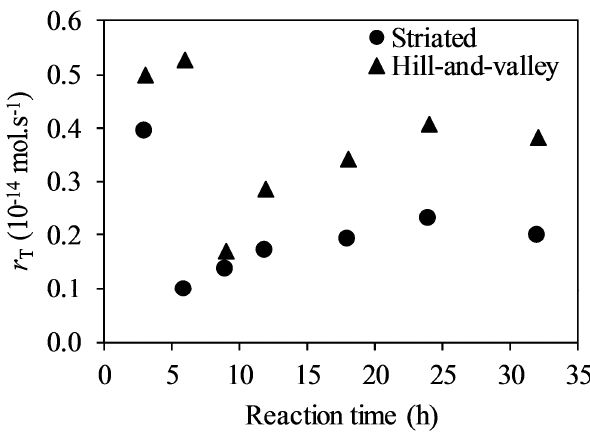
Figure 4. Total material flux rate ( r T ) change over time within the sub-sections in Figure 3c,d corresponding to striated and hill-and-valley surface morphologies, respectively. This rate was calculated from the total volume of calcite lost in each reaction time interval. The sample was reacted in a fluid cell using 2 mmol Na 2 CO 3 solution with pH 8.7, at room temperature.